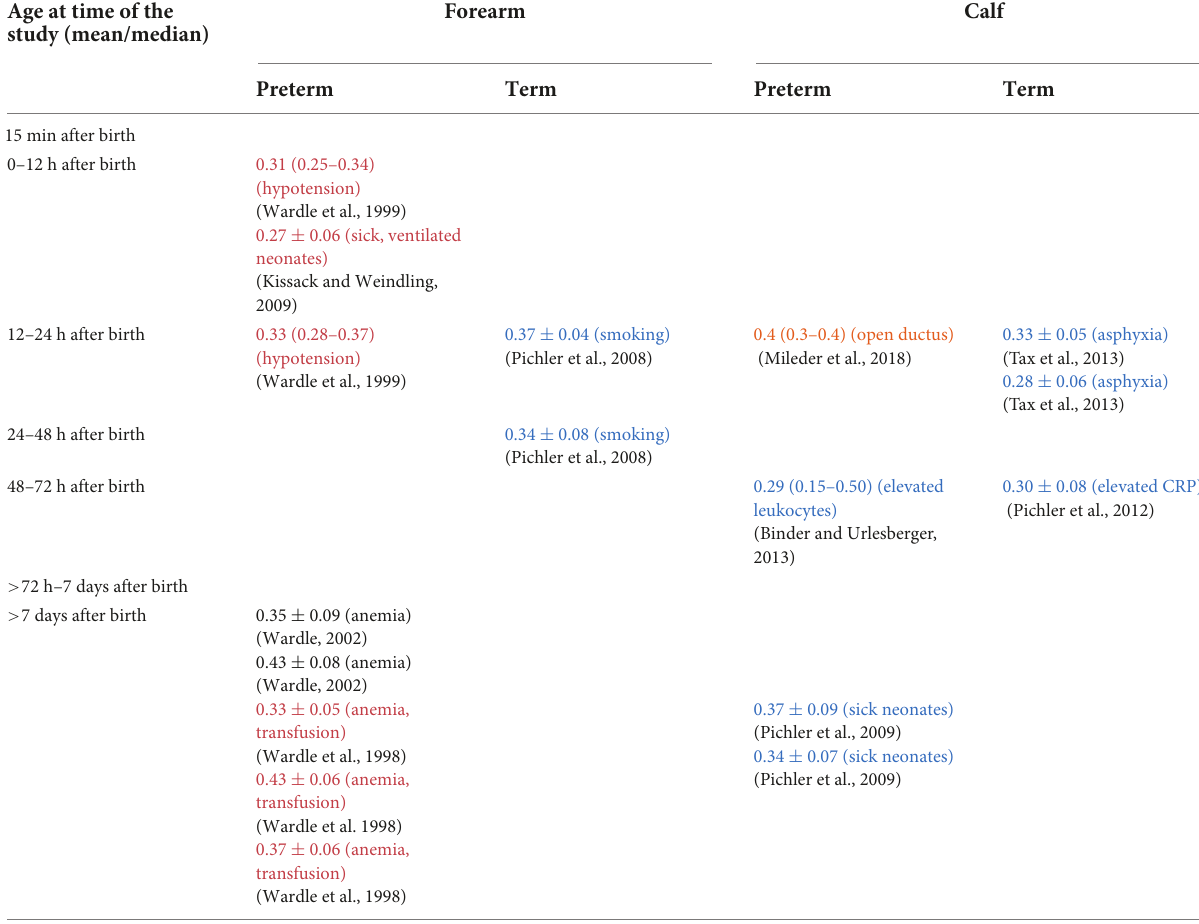
TABLE 4 pFOE in preterm and term neonates with pathological findings/conditions sorted according to the time point of measurement after birth. Age at time of the Forearm study (mean/median)